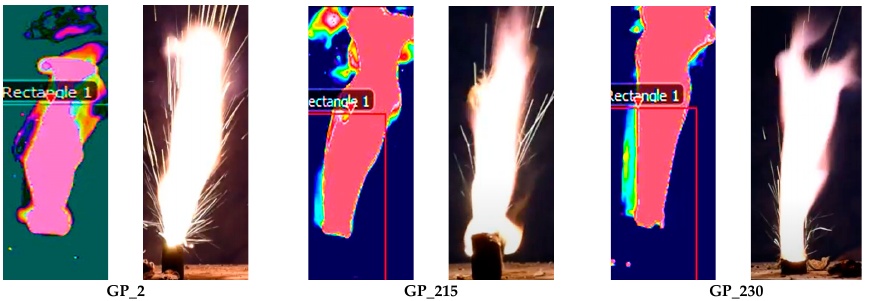
Figure 11. Flame configuration for rocket propellant formulations.